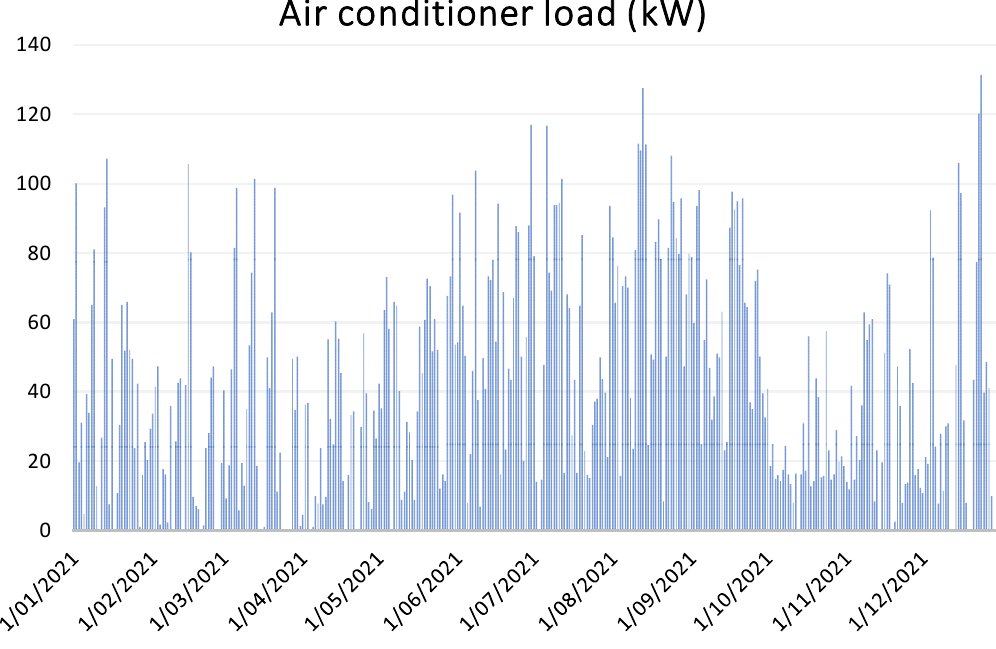
Figure 6. The simulated air conditioner load profile.